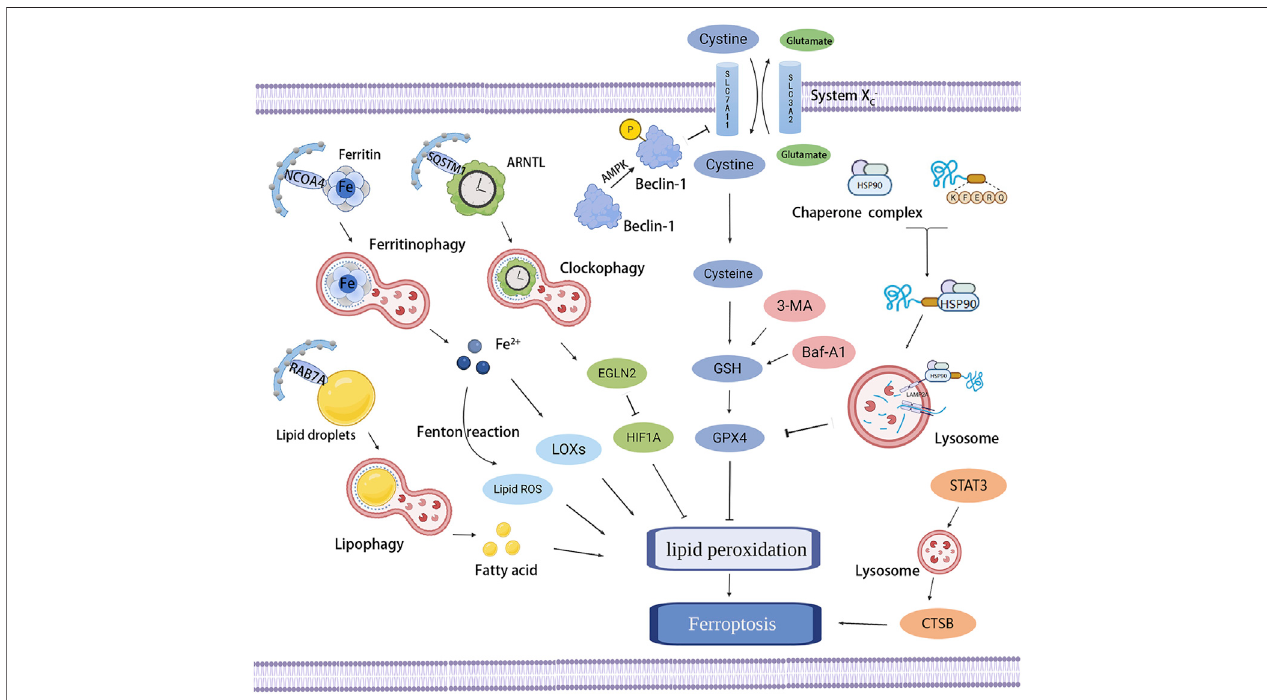
FIGURE 5 | Association between autophagy and ferroptosis. Several types of selective autophagy, including ferritinophagy, lipophagy, clockophagy, and CMA, promote lipid peroxidation and ferroptosis by promoting the degradation of ferritin, lipid droplets, ARNTL, and GPX4, respectively. Beclin-1 is phosphorylated by AMPK and then facilitates ferroptosis by binding and blocking the activity of system x c − . Autophagy inhibitors (e.g., 3-MA, Baf-A1) can prevent GSH depletion-dependent ferroptosis. STAT3-mediated CTSB expression and lysosomal cell death promote ferroptosis.